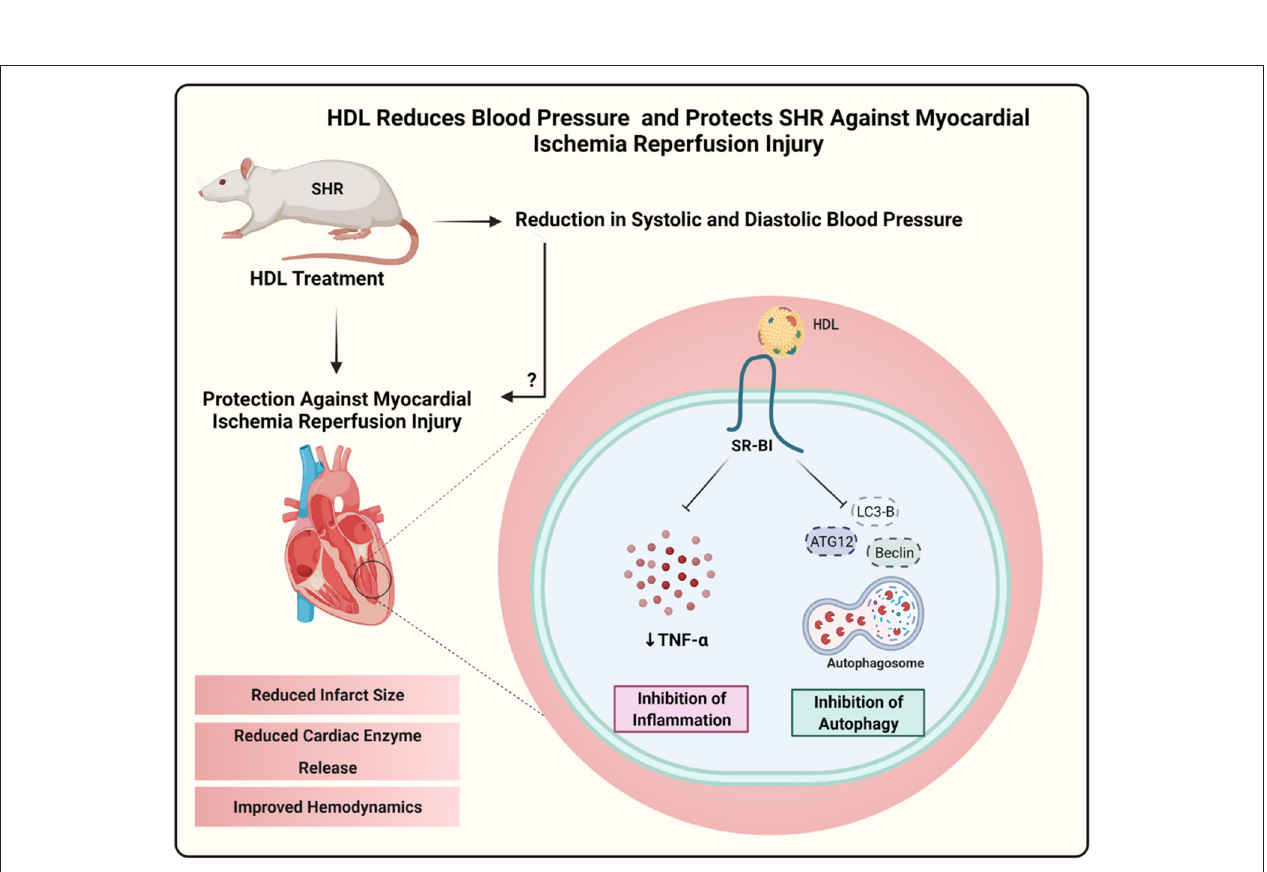
FIGURE 11 | Proposed mechanism of HDL mediated cardiac protection in SHR. Chronic, in vivo treatment with HDL reduced blood pressure and protected SHR against myocardial I/R injury. HDL induced cardiac protection required SR-BI and involved attenuation of autophagy and inflammation. Created with Biorender.com.